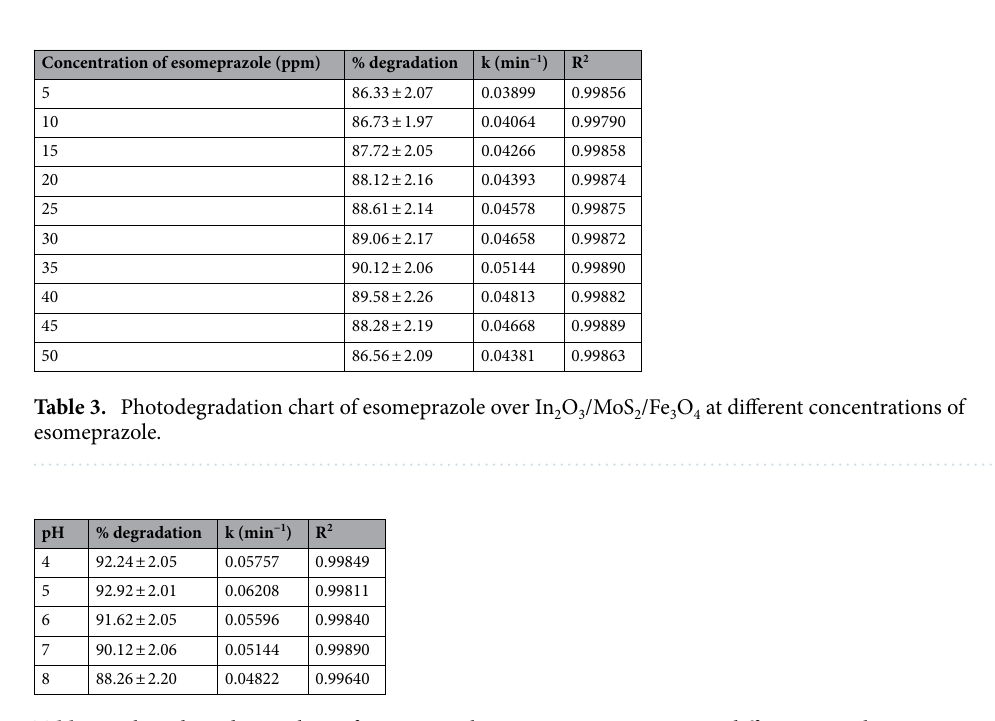
Table 4. Photodegradation chart of esomeprazole over In 2 O 3 /MoS 2 /Fe 3 O 4 at different pH values.